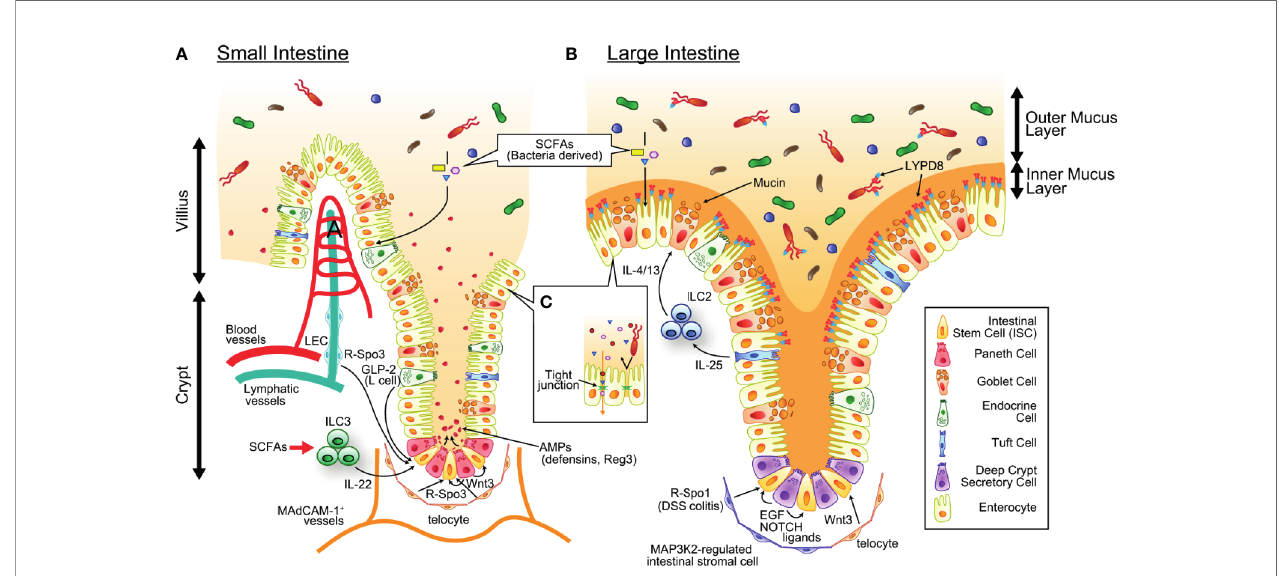
FIGURE 1 | The mechanism maintaining intestinal homeostasis. ISCs residing at the crypt base give rise to all cell lineages in the epithelium and are supported by growth factors produced by de fi nitive and putative niche components. SCFAs produced by commensal bacteria serves as energy source of intestinal epithelial cells. (A) In the small intestine, Paneth cells and telocytes produce Wnt3, telocytes and LECs produce R-Spo3, L cells produce GLP2, and ILC3s (green round cells in the fi gure) produce IL-22. Paneth cells also produce a large amount of AMPs such as a -defensins and REG3, and maintain healthy intestinal microbiota. (B) In the colon, deep crypt secretory cells produce EGF and NOTCH ligands, telocytes produce WNT3, and MAP3K2-regulated intestinal stromal cells produce R-Spo1. There are tremendous numbers of bacteria in the colonic lumen, which is segregated from epithelial cells by the inner mucus layer containing mucins produced by goblet cells and antimicrobial molecules such as REG3 and LYPD8 produced by enterocytes. IL-25 produced from Tuft cells stimulates ILC2s (blue round cells in fi gure) to secrete goblet cell growth factors such as IL-4 and IL-13. SCFAs produced by commensal bacteria serves as energy source of intestinal epithelial cells. (C) The intestinal epithelial tight junctions exhibit both size and charge selectivity and regulate the selective paracellular permeability, inhibiting penetration of bacteria and bacterial components while permitting the passage of water, ions, and small molecules. AMP, antimicrobial peptide; EGF, epithelial growth factor; GLP-2, Glucagon- like peptide 2; LEC, lymphatic endothelial cell; ILC2/3, type 2/3 innate lymphoid cell; IL-4/13/22/25, interleukin-4/13/22/25; ISC, intestinal stem cell; LYPD8, Ly6/ PLAUR domain-containing protein 8; R-Spo1/3, R-spondin 1/3; SCFA, short-chain fatty